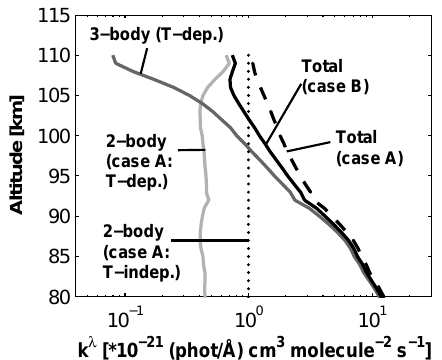
Fig. 1. The two-body, three-body and total effective rate coeffi- cients for the NO 2 chemiluminescence at around 540nm. The light grey profile is the temperature dependent two-body rate coefficient · F ( k λ 2 (T )) ; the dotted line is the temperature independent two- 1 body rate coefficient, i.e. k λ ; the dark grey profile is the temper- 1 ature dependent three-body rate coefficient (essentially Eq. 4 with F 2 (T ) = 0 ) ; the dashed black profile is the total effective bimolecu- lar rate coefficient with no temperature dependence in the two-body reaction (“case A” in the text, i.e. Eq. 4 with F 2 (T ) = 1 ) ; and the black profile is the total effective bimolecular rate coefficient with the temperature dependence in both the two- and three-body reac- tions (“case B” in the text).